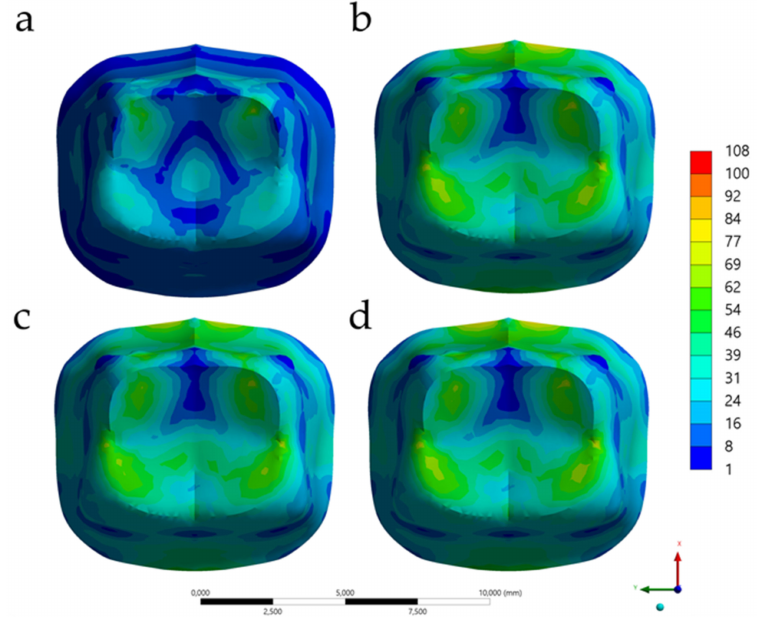
Figure 5. Stress distribution (MPa) in the primary crown’s occlusal surface according to the restorative material: ( a ) PEKK; ( b ) Titanium; ( c ) CoCr; and ( d )